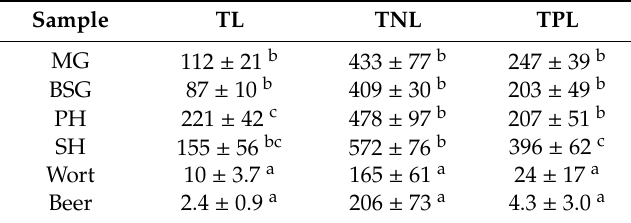
Table 4. The in vitro biological activities of the total lipids (TL), total neutral lipids (TNL), and total polar lipids (TPL) of the beer and brewing by-products against thrombin-induced human platelet aggregation. Results are expressed as an IC 50 in micrograms ( µ g) of each lipid extract. The hPRP concentration was approximately 500,000 platelets µ L − 1 . The final concentration of thrombin in the cuvette was 0.1–1.0 mU / mL. All experimental analyses were carried out in triplicate (mean ± SD, n = 3). Sample TL TNL